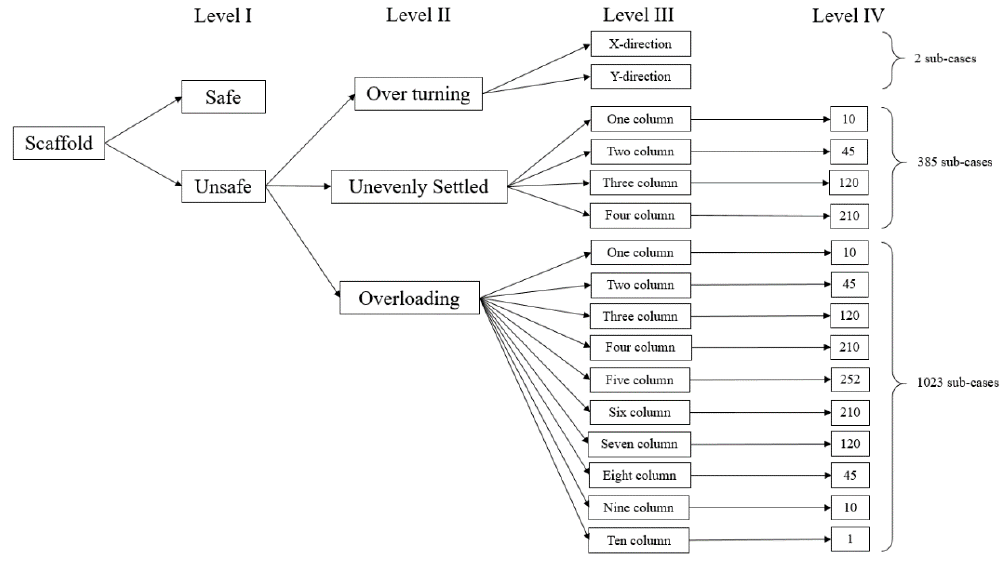
Figure 3. Hierarchical classification of safety conditions based on the divide-and-conquer technique.